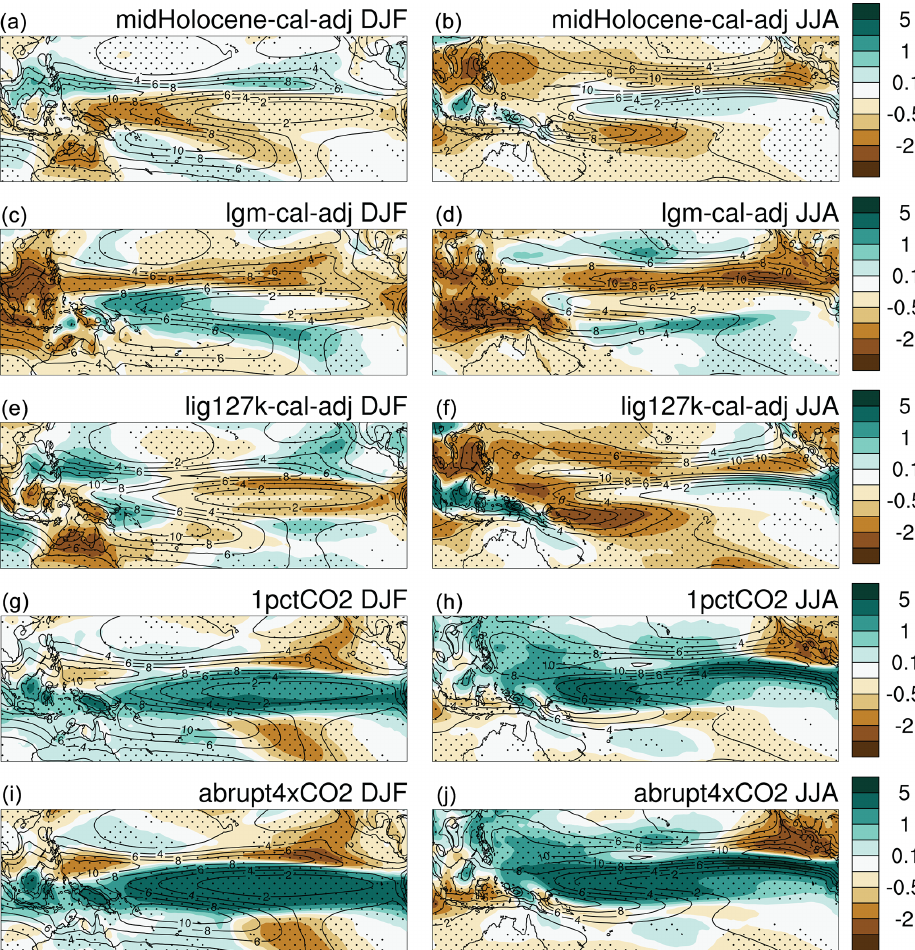
Figure 7. Ensemble mean seasonal changes in precipitation in experiment minus pre-industrial control simulations: (a) DJF midHolocene , (b) JJA midHolocene , (c) DJF lgm , (d) JJA lgm , (e) DJF lig127k , (f) JJA lig127k , (g) DJF 1pctCO2 , (h) JJA 1pctCO2 , (i) DJF abrupt4xCO2 , and (j) JJA abrupt4xCO2 . The ensemble mean temperature pattern in the pre-industrial control simulations is shown as black contours. Units are mmd − 1 . Stippling indicates that more than two-thirds of the ensemble members agree on the sign of the